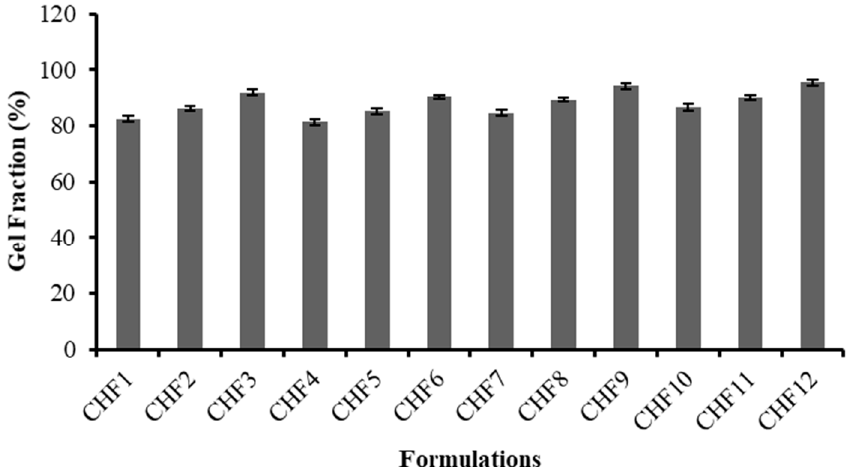
Figure 3. Gel fraction (%) of formulations CHF1 ‐ CHF12.